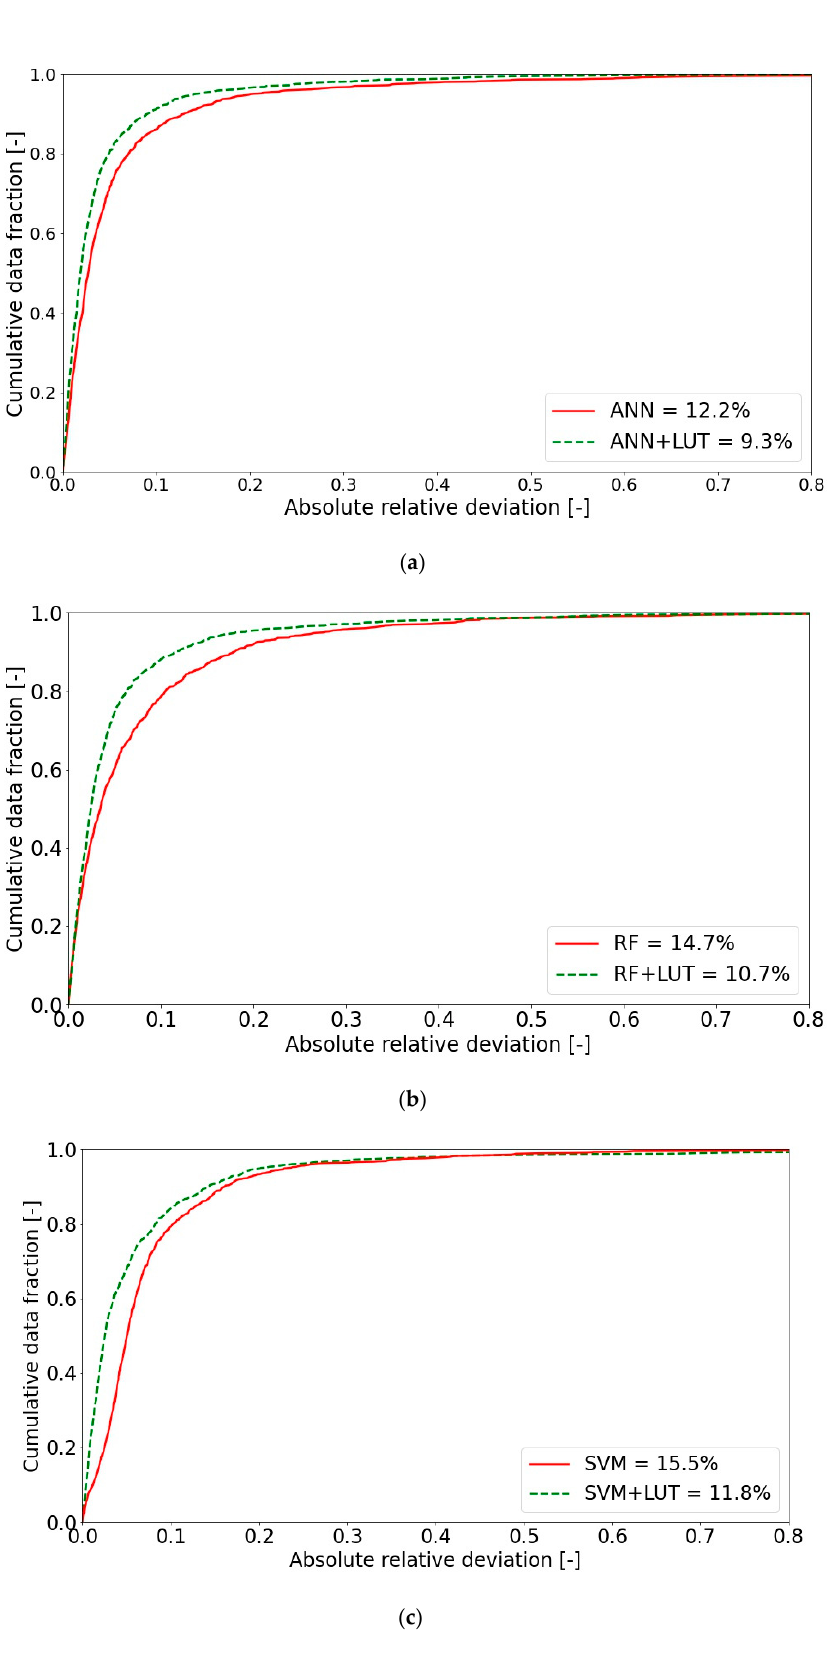
Figure 7. Absolute-relative deviation vs. data fraction of hybrid ANN+LUT ( a ), RF+LUT ( b ), SVM+LUT ( c ), and standalone ML